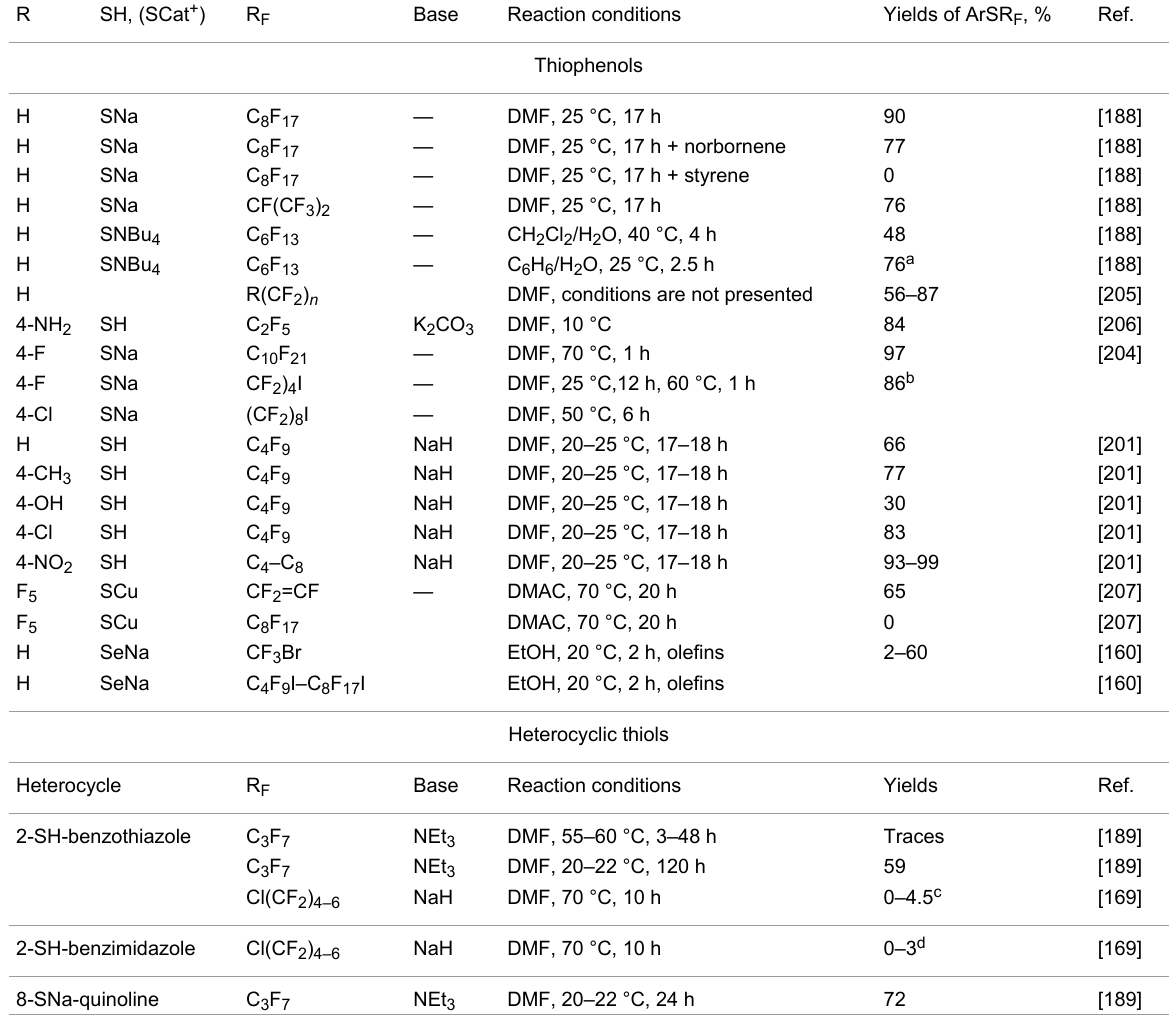
Table 11: Reactions of thiols RC 6 H 4 SH and HetArSH with R F I in organic solvents and in biphasic conditions without initiators. R Base Reaction conditions Yields of ArSR F , %